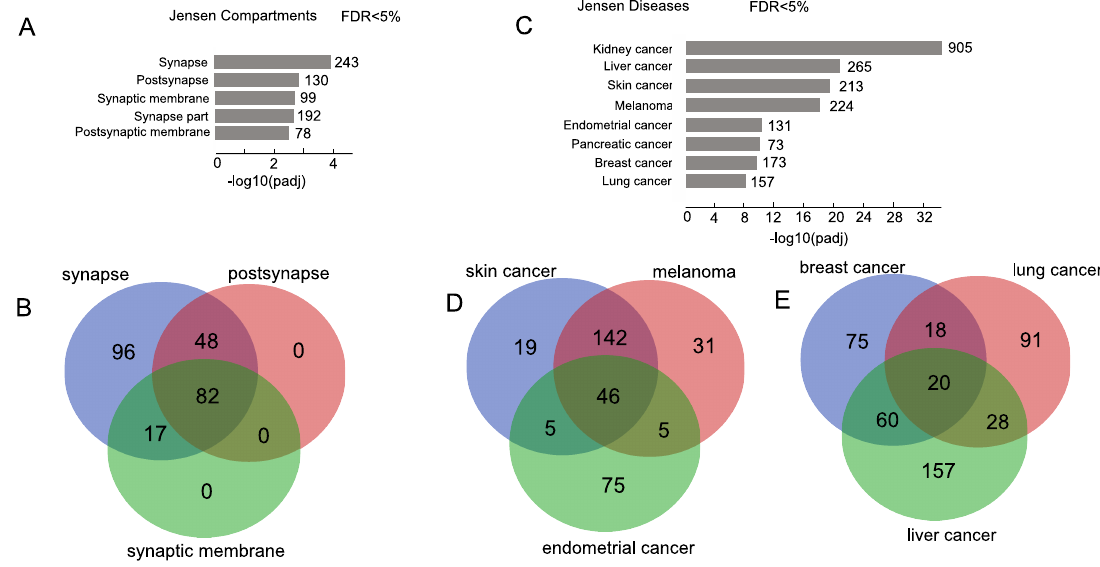
Figure 2. Search of rDNA-contacting genes for enriched terms using the Jensen Compartments and Jensen Diseases libraries of Enrichr. ( A ) The top five compartments associated with rDNA-contacting genes in the library. The values to the right of the bars show the number of rDNA-contacting genes associated with a term. The list of the corresponding genes is shown in Table S4. ( B ) The diagram shows the number of rDNA-contacting genes associated with three compartments. The list of the corresponding genes is shown in Table S5. ( C ) The top eight diseases highly associated with rDNA-contacting genes in the library. The values to the right of the bars show the number of rDNA-contacting genes associated with a term. The list of the corresponding genes is shown in Table S6. ( D ) Venn diagram showing the intersections between rDNA-contacting genes associated with skin cancer, melanoma, and endometrial cancer. The list of the corresponding genes is shown in Table S7. ( E ) Venn diagram showing the intersections between rDNA-contacting genes associated with breast, lung, and liver cancers. The list of the corresponding genes is shown in Table